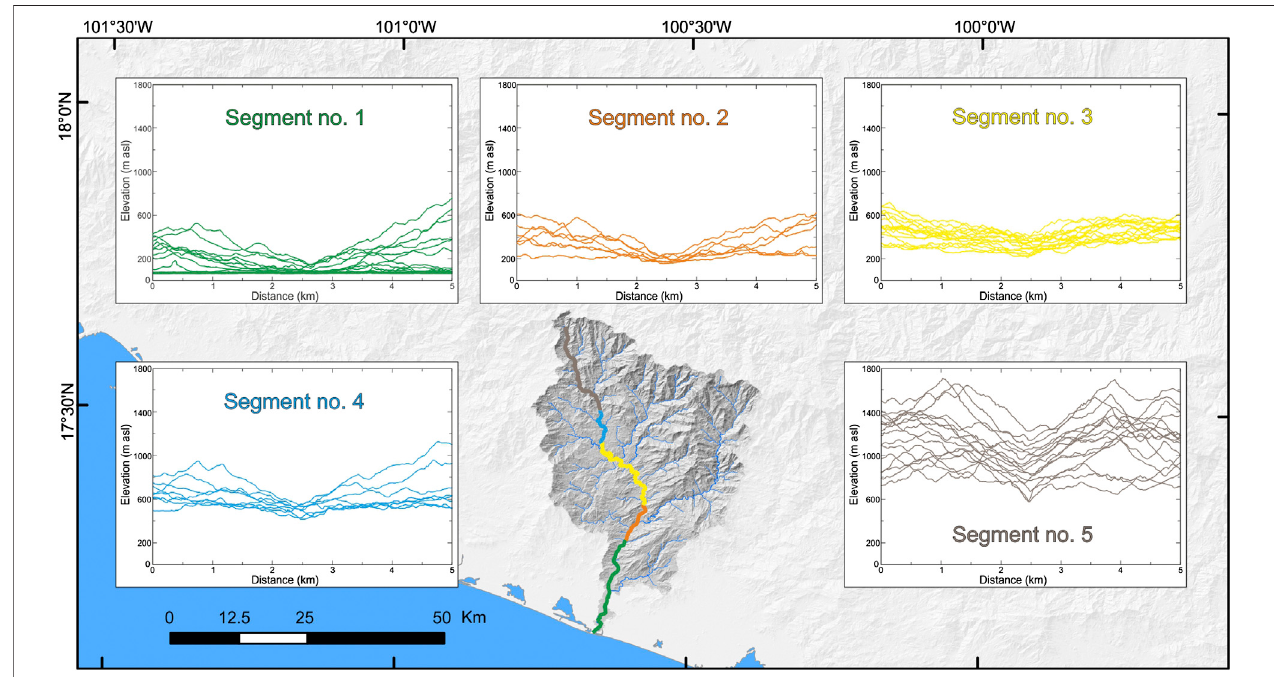
FIGURE 3 | Segments along the Tecpan River and cross-sections of the Tecpan valley (5 km long) within de fi ned segments.